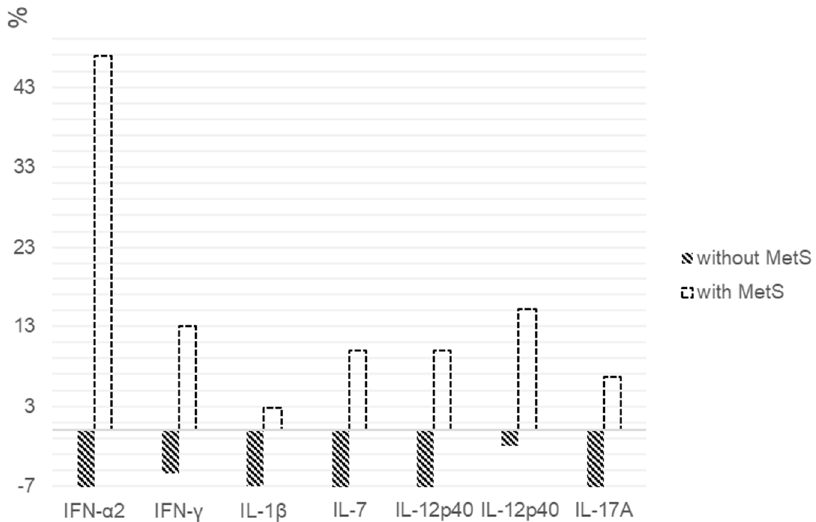
Figure 3. Percentage changes in cytokine levels after 6 weeks of quetiapine or olanzapine therapy in patients with and without MetS. We calculated the individual percentage changes in the indicators for each patient separately using the formula: ((V2 − V1)/V1) × 100, where V1 is the initial value before therapy, and V2 is the final value after therapy. The data in the figure are presented as the median of the changes in the indicators. The figure shows only the statistically significant differences according to the Mann–Whitney U test. Table 4. Serum concentrations of the cytokines (pg/mL) in patients with and without MetS during 6 weeks of quetiapine or olanzapine therapy, Me (Q1; Q3).